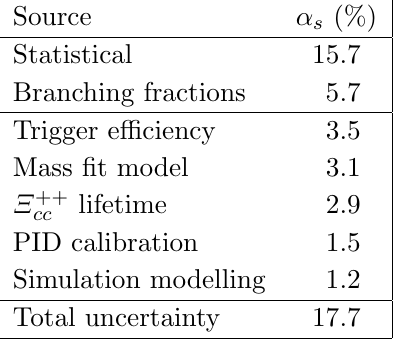
Table 1 . Systematic and statistical uncertainties on the single-event sensitivity (cid:11) s . K (cid:0) (cid:25) + (cid:25) + ) and pK (cid:0) (cid:25) + ) have a combined uncer- the branching fractions ( D + ( (cid:3) + c ! B ! B tainty of 5.7%. The systematic uncertainties from the di(cid:11)erent sources discussed above are considered uncorrelated and are added in quadrature to give a total systematic uncertainty of 5.8%. Adding all sources of uncertainty in quadrature gives a total uncertainty of 17.7% on the (cid:11) s